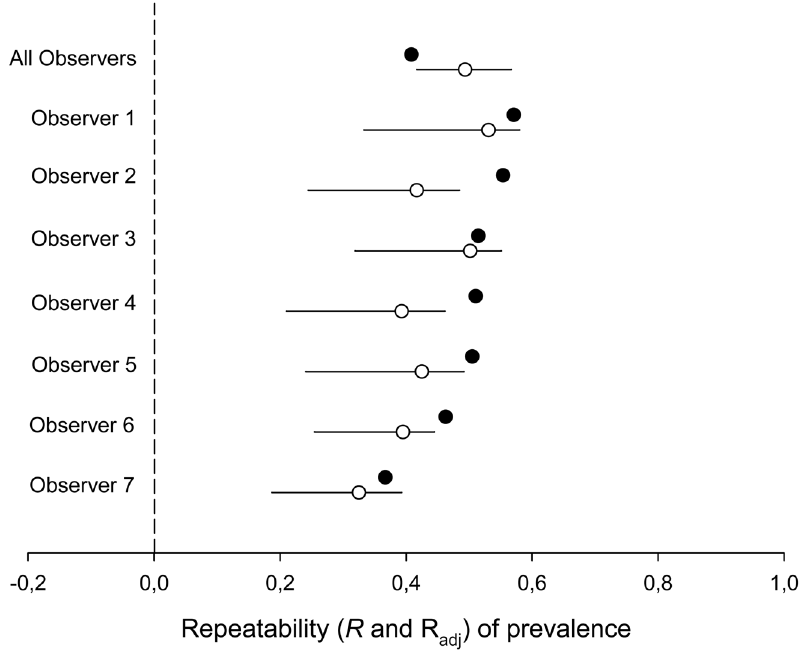
Figure 3. Species repeatability and adjusted repeatability of feather mite prevalence. Species repeatability (R; white circles) and adjusted repeatability (R adj ; black circles) for feather mite prevalence with corresponding 95% confidence interval estimates for different intensity data subsets (either the entire dataset, ‘‘All observers’’, or for data from seven different researchers separately). The following confounding effects were retained in the models: ‘‘breeding’’ was retained for observers 1–7; "habitat" was also retained for observers 2, 5 and 6; the ‘‘PC1’’ was also added for observers 1 and 4; finally, six variables of the spatial autocorrelation term were retained for observer 4. For ‘‘All Observers’’ the final model included the fixed effects shown in Table 1. All R and R adj estimates were statistically significant at a =0.001. 95% CI could not be calculated for R adj (see Methods).